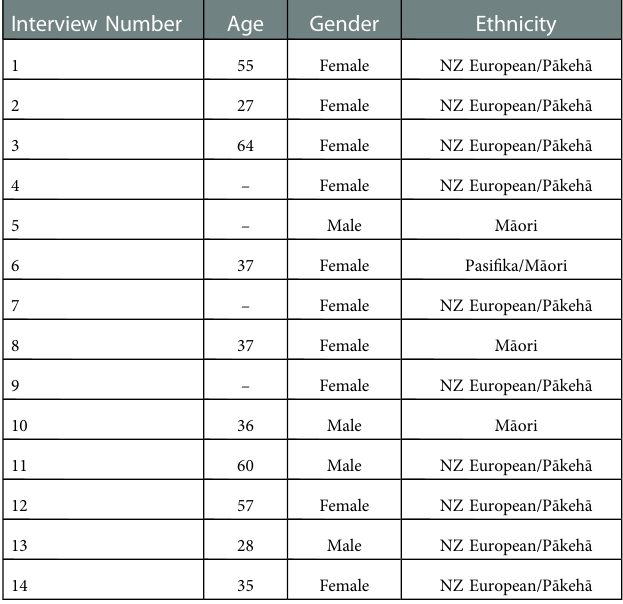
TABLE 7 Demographics of semi-structured interview participants Interview